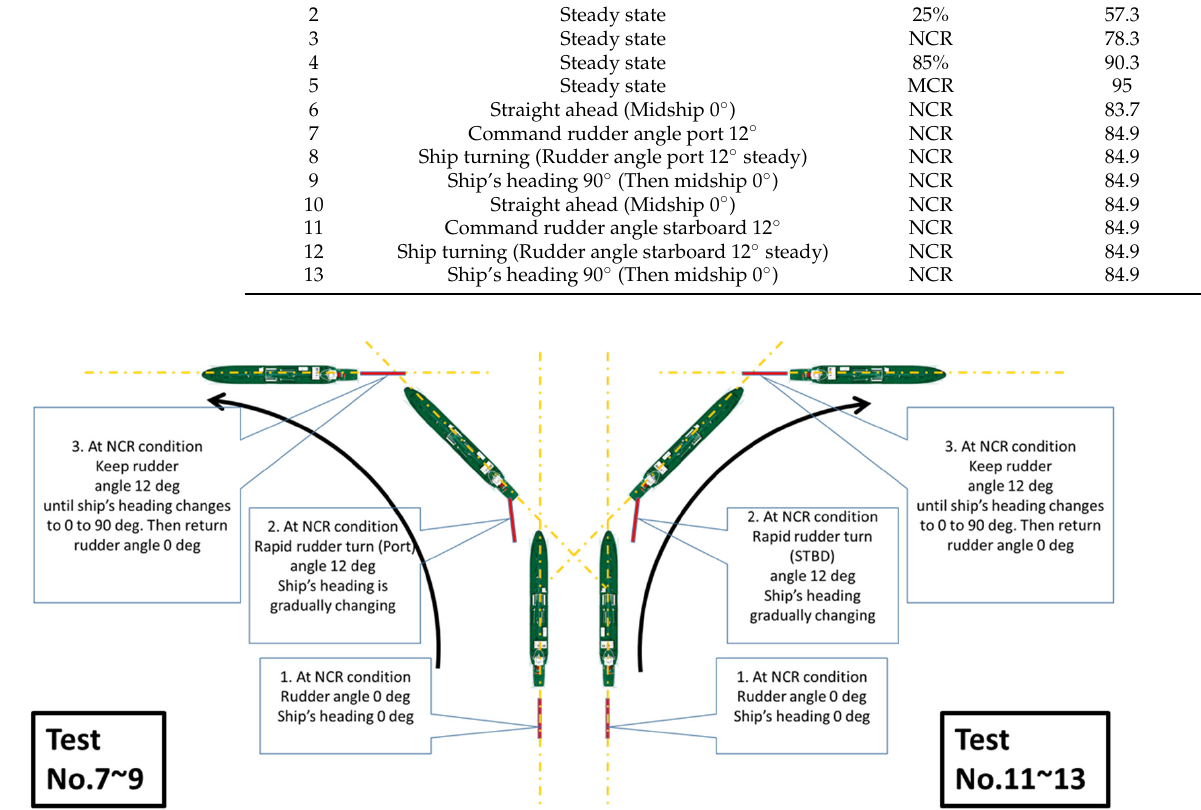
Table 3. Test conditions of the case study ship.